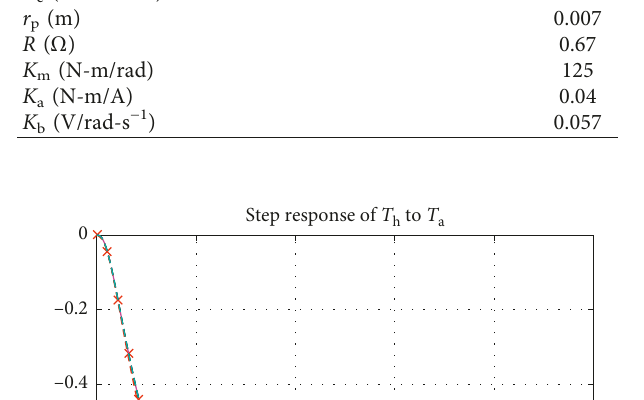
Figure 5: The bump response of EPS system with a sensor failure.